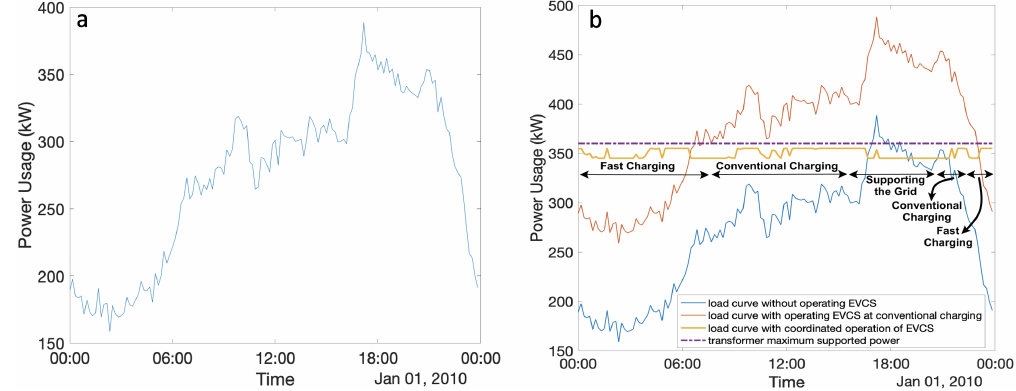
Figure 7. ( a ) Normal load curve over a day. ( b ) Comparison of different load curves over a day.